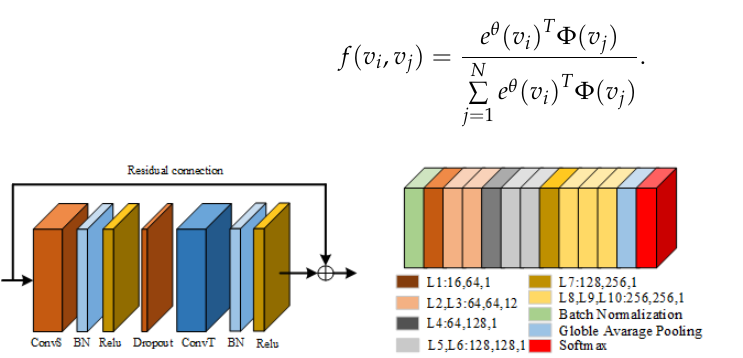
Figure 2. Original adaptive graph convolution module ( left ) and adaptive graph convolution model ( right )